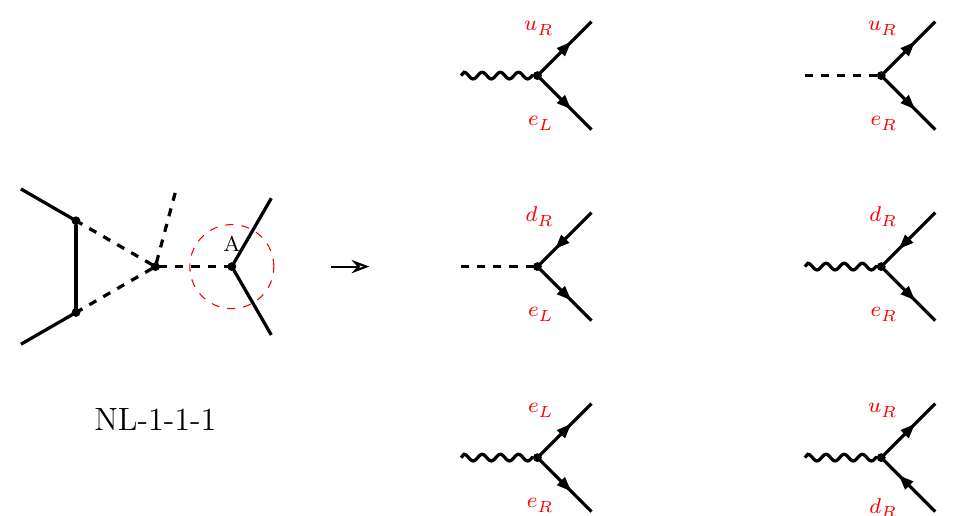
to the external lines of the diagram 4